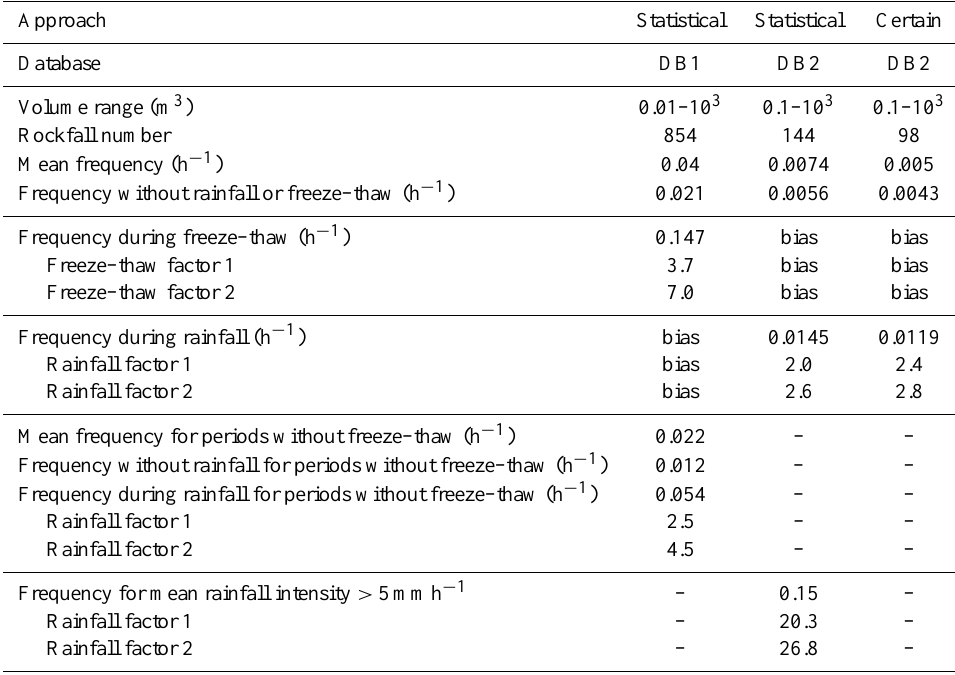
Table 6. Influence factors for different situations. Factor 1 is related to the mean frequency of rockfalls. Factor 2 is related to the frequency without rainfall or